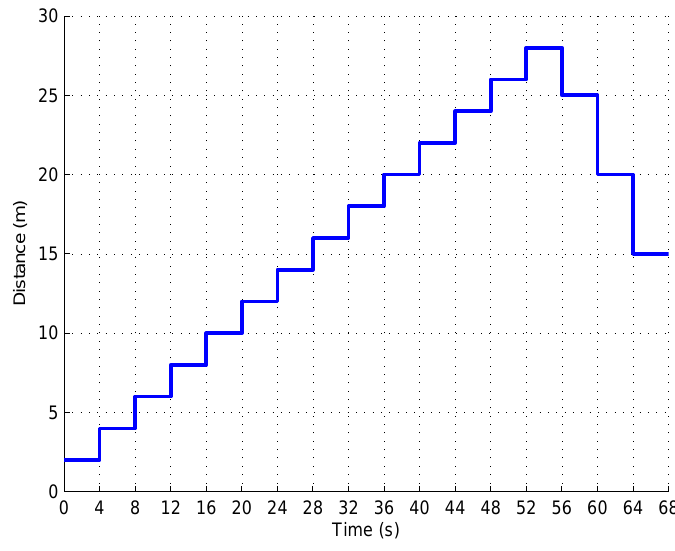
Figure 6. Variable distance in simulations.